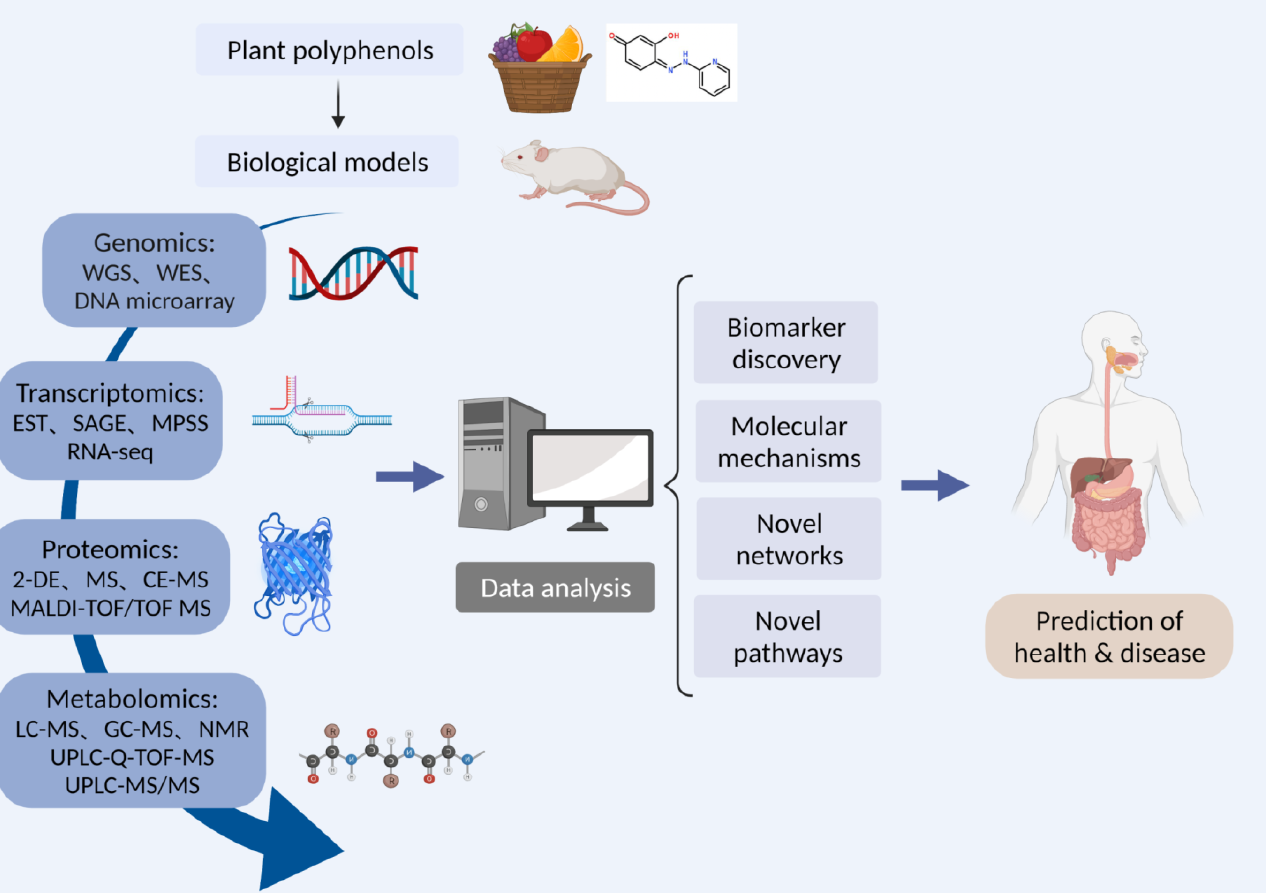
Figure 1. The strategy of foodomics to study the bioactivities of polyphenols. 2-DE: two-dimensional gel electrophoresis; CE-MS: capillary electrophoresis mass spectrometry; EST: expression sequence tags technology; GC: gas chromatography; LC: liquid chromatograph; MPSS: massively parallel signature sequencing; MALDI-TOF/TOF: matrix-assisted laser desorption ionization time-of-flight/time-of-flight; MS: mass spectrometry; NMR: nuclear magnetic resonance; RNA-seq: RNA sequencing; SAGE: serial analysis of gene expression; UPLC-Q-TOF: ultra-performance liquid chromatography to quadrupole time-of-flight; WES: whole exome sequencing; WGS: whole genome